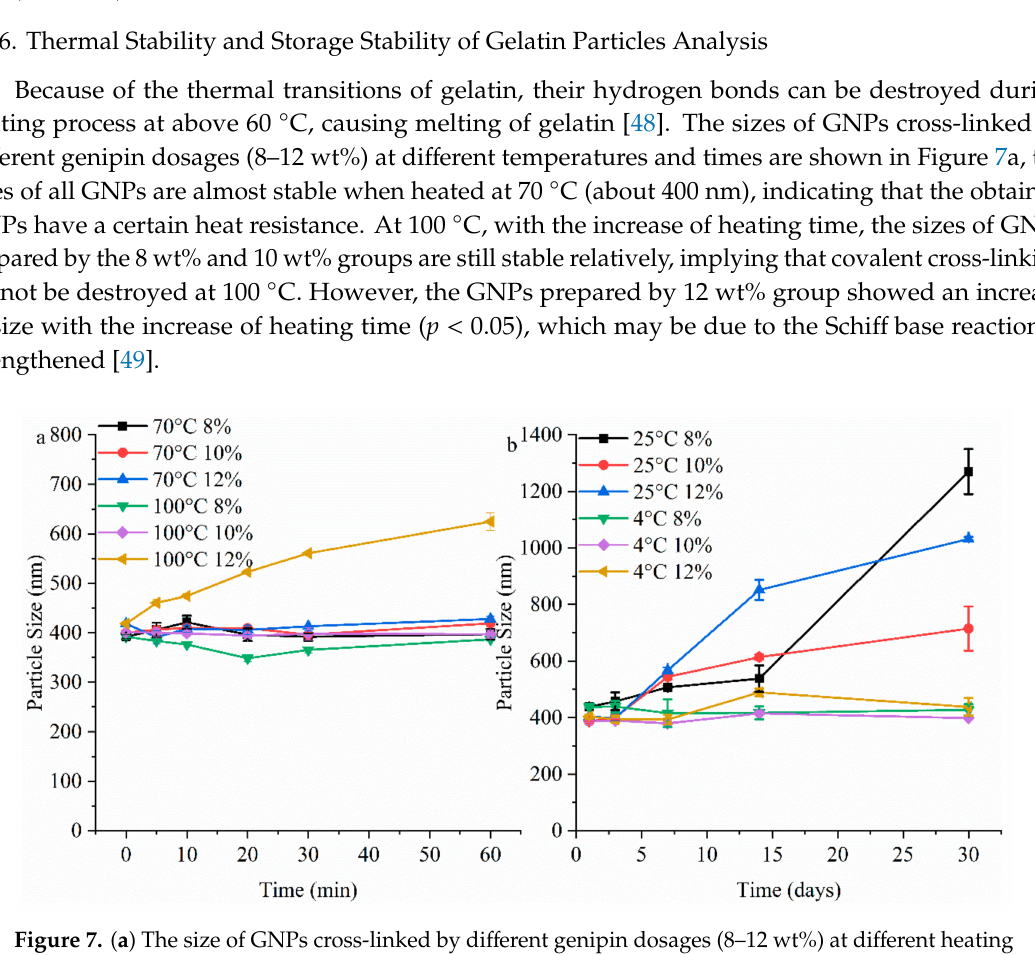
Figure 6. The three-phase contact angle ( θ ) of GNPs cross-linked by di ff erent genipin dosages (8–12 wt%).